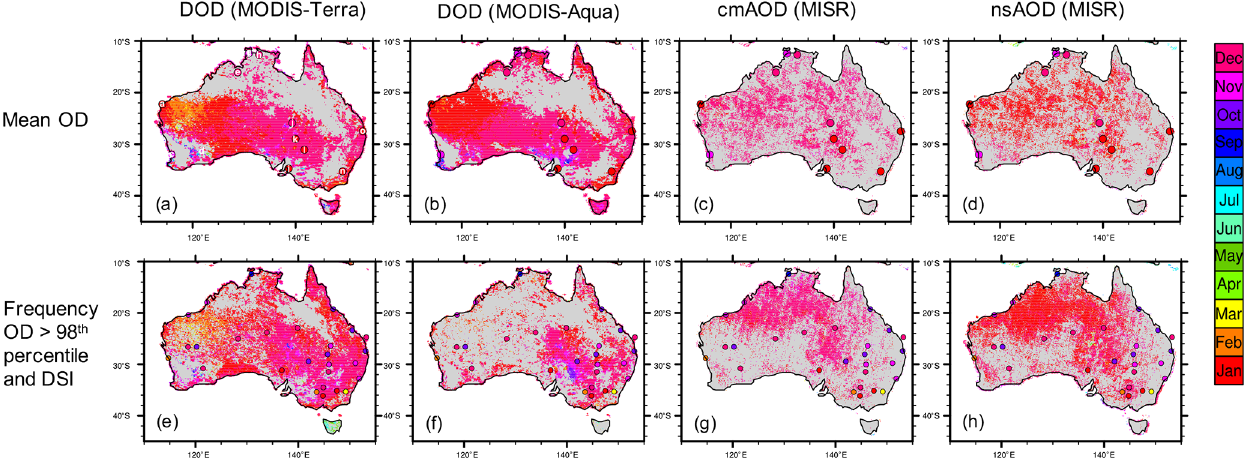
Figure 3. Month of peak dust activity over Australia during 2000–2019. In (a–d) , the map represents average DOD from MODIS-Terra and MODIS-Aqua and cmAOD and nsAOD from MISR. Filled circles represent DOD from 15 AERONET sites, which are identical in (a–d) . In (e–h) , the map represents frequency of DOD proxies exceeding the 98th percentile of all observations from each instrument. Filled circles represent DSI from 182 weather stations. Only statistically meaning seasonal cycle peak month is shown for each dustiness measure, as outlined in Sect.